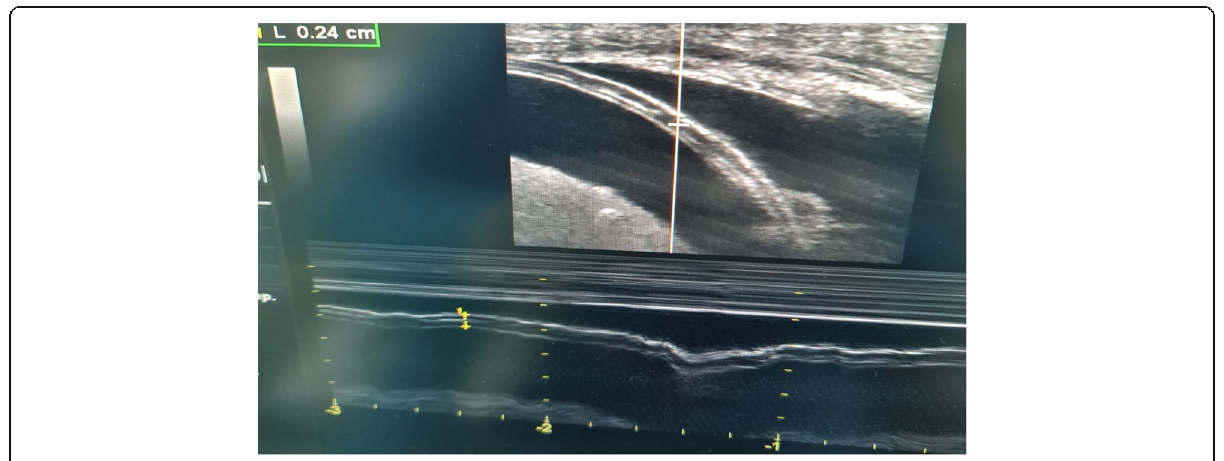
Fig. 2 Diaphragm thickness during expiration 0.24 cm